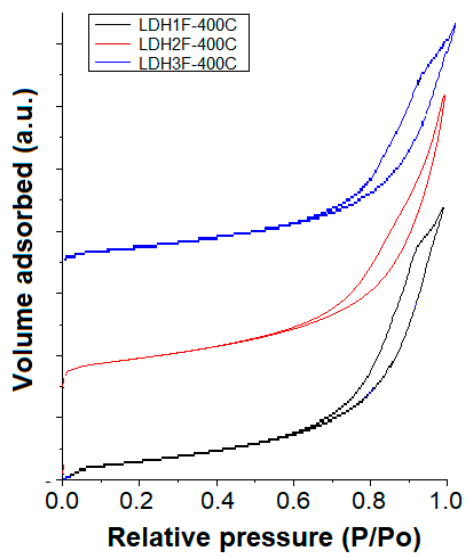
Figure 4. N 2 physisorption isotherms of activated Mg / Fe layered double hydroxides.